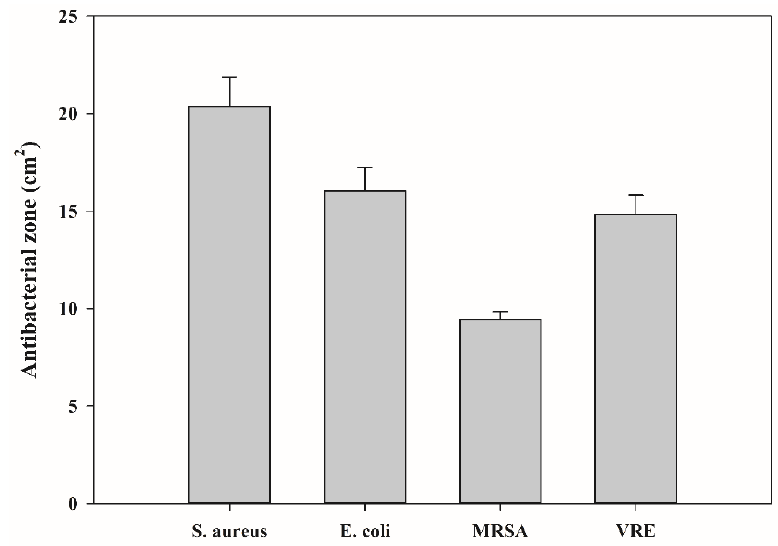
Figure 3. Antibacterial activity of Bioelastomer – MPE 15% against gram-positive ( S. aureus ), Gram- negative ( E. coli ), and antibiotic-resistant bacteria (MRSA and VRE).